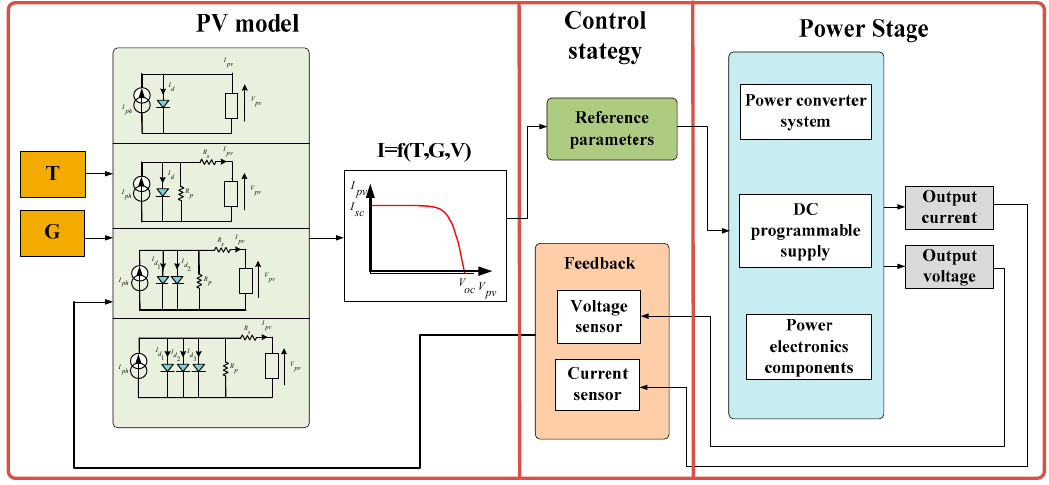
Figure 1. General PV emulator parts.